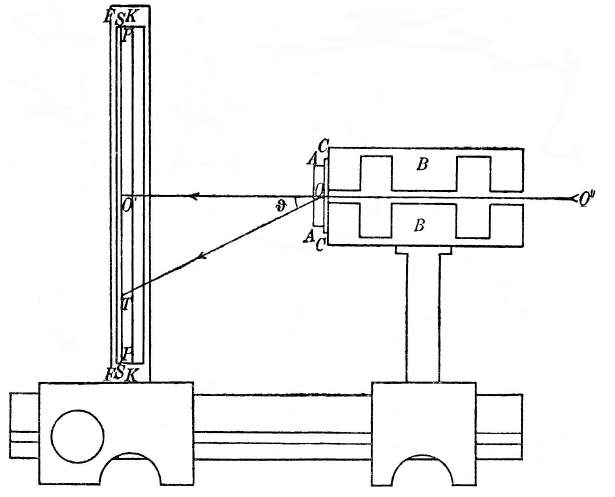
Figure 8. The setup employed by Schiebold (1919) in his research on the detailed structure of calcite by means of X-ray di ff raction. The narrow X-ray beam O”O is deflected at various angles θ by a 1-mm thick crystal plate AA (fixed to the cover glass CC) and is then recorded by the photographic plate PP. BB is a lead screen. Schiebold’s specimens were all cut from a “wasserklares Spal- tungsrhomboeder von Isländer